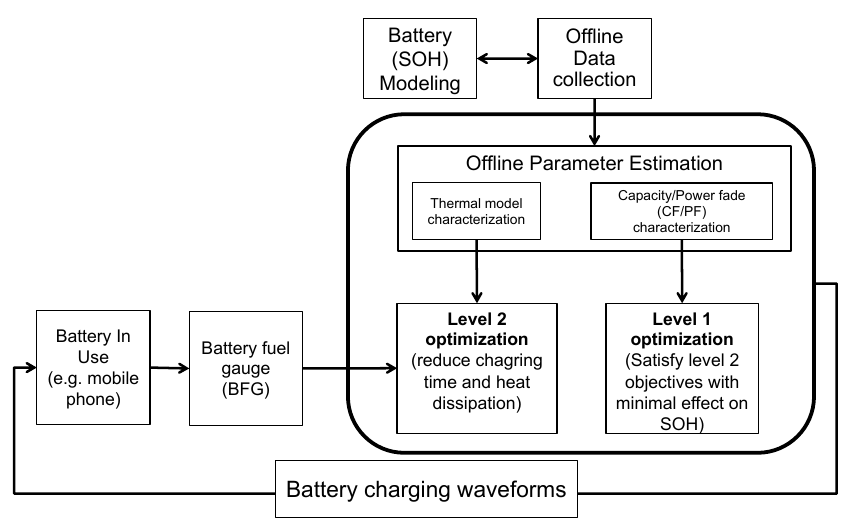
Figure 9. Elements of a smart (optimal)